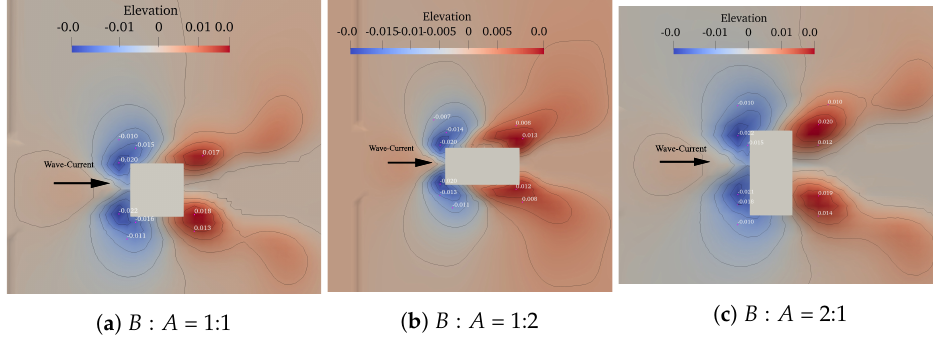
Figure 10. Contours of bed topography for combined wave − current ( U cw = 0.4) case for KC = 10 for varying aspect ratios of the rectangular pile. The side ( B ) of the rectangular pile is 0.08 m, and the period (T) of the wave is 4.5 s. Duration of the simulation run 3600 s. Table 2. Summary of the validation and analysis conditions employed in this